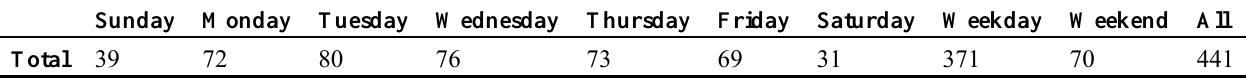
Table 9. Total charging energy demanded * by day